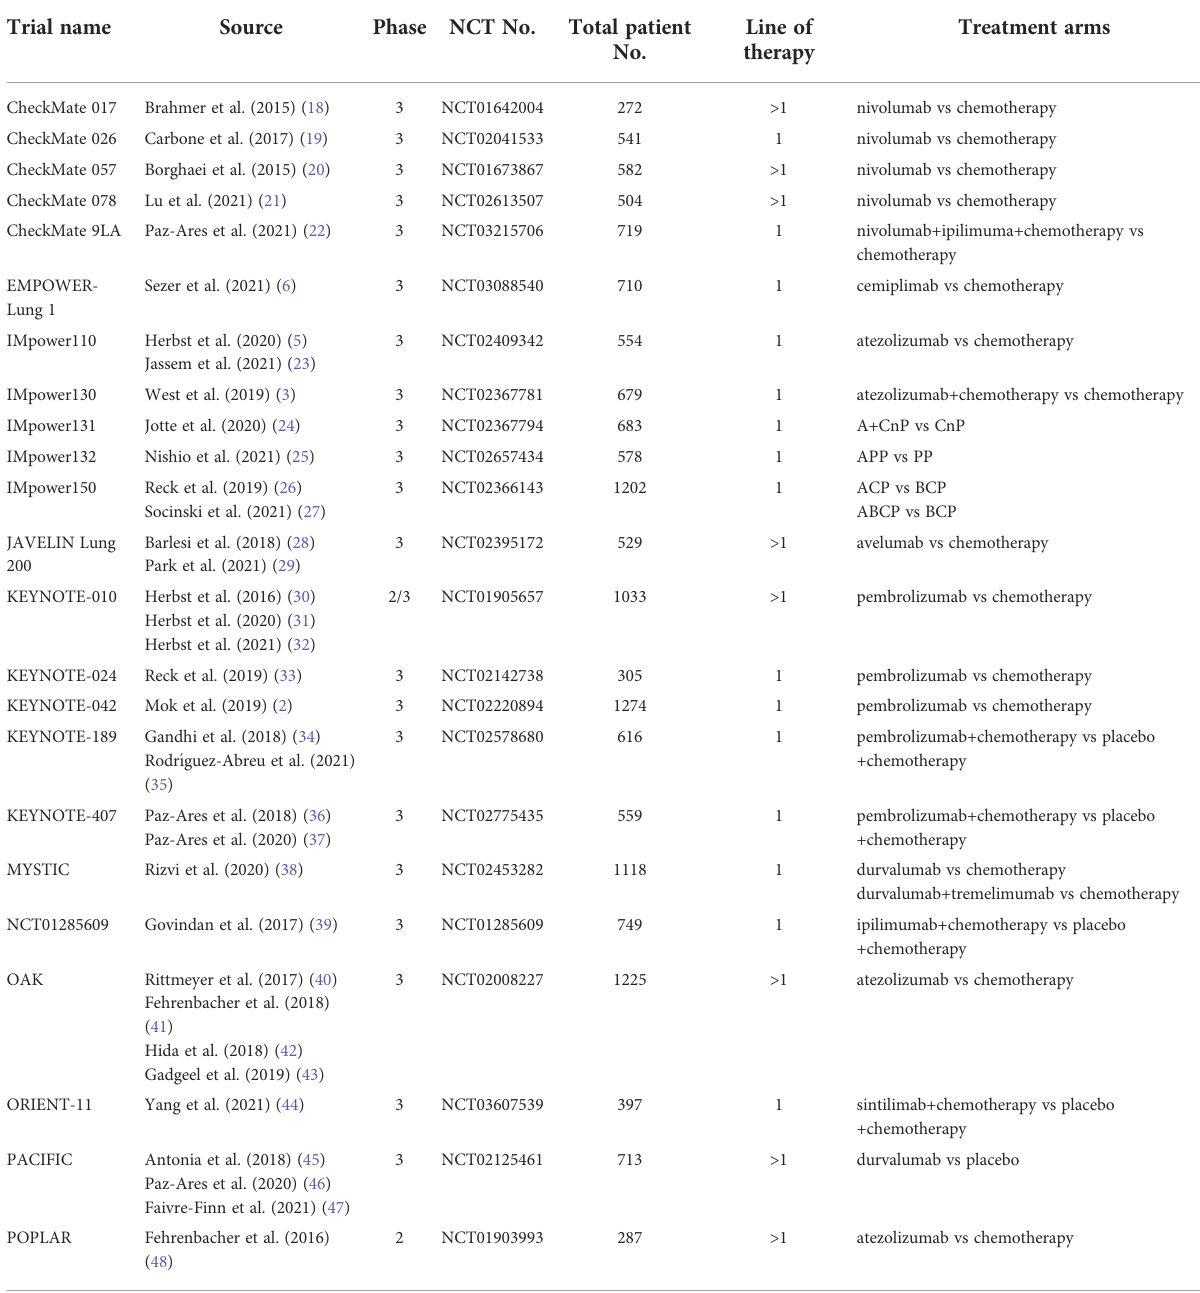
TABLE 1 List of the studies included in this meta-analysis. Source Phase NCT